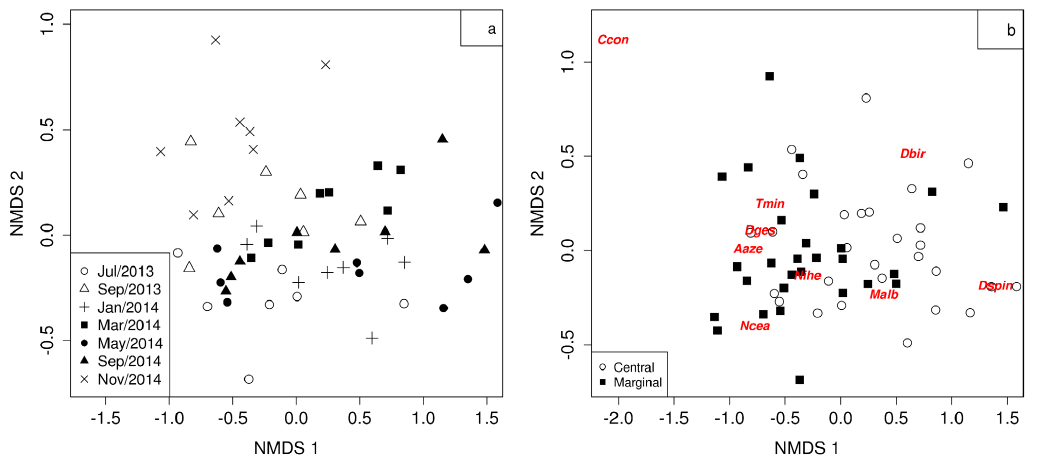
Figure 5. Non-metric multidimensional scaling (NMDS) based on the temporal ( a ) and spatial ( b ) variation of the microcrustacean assemblages structure between July 2013 and November 2014 of the reservoir Barragem da